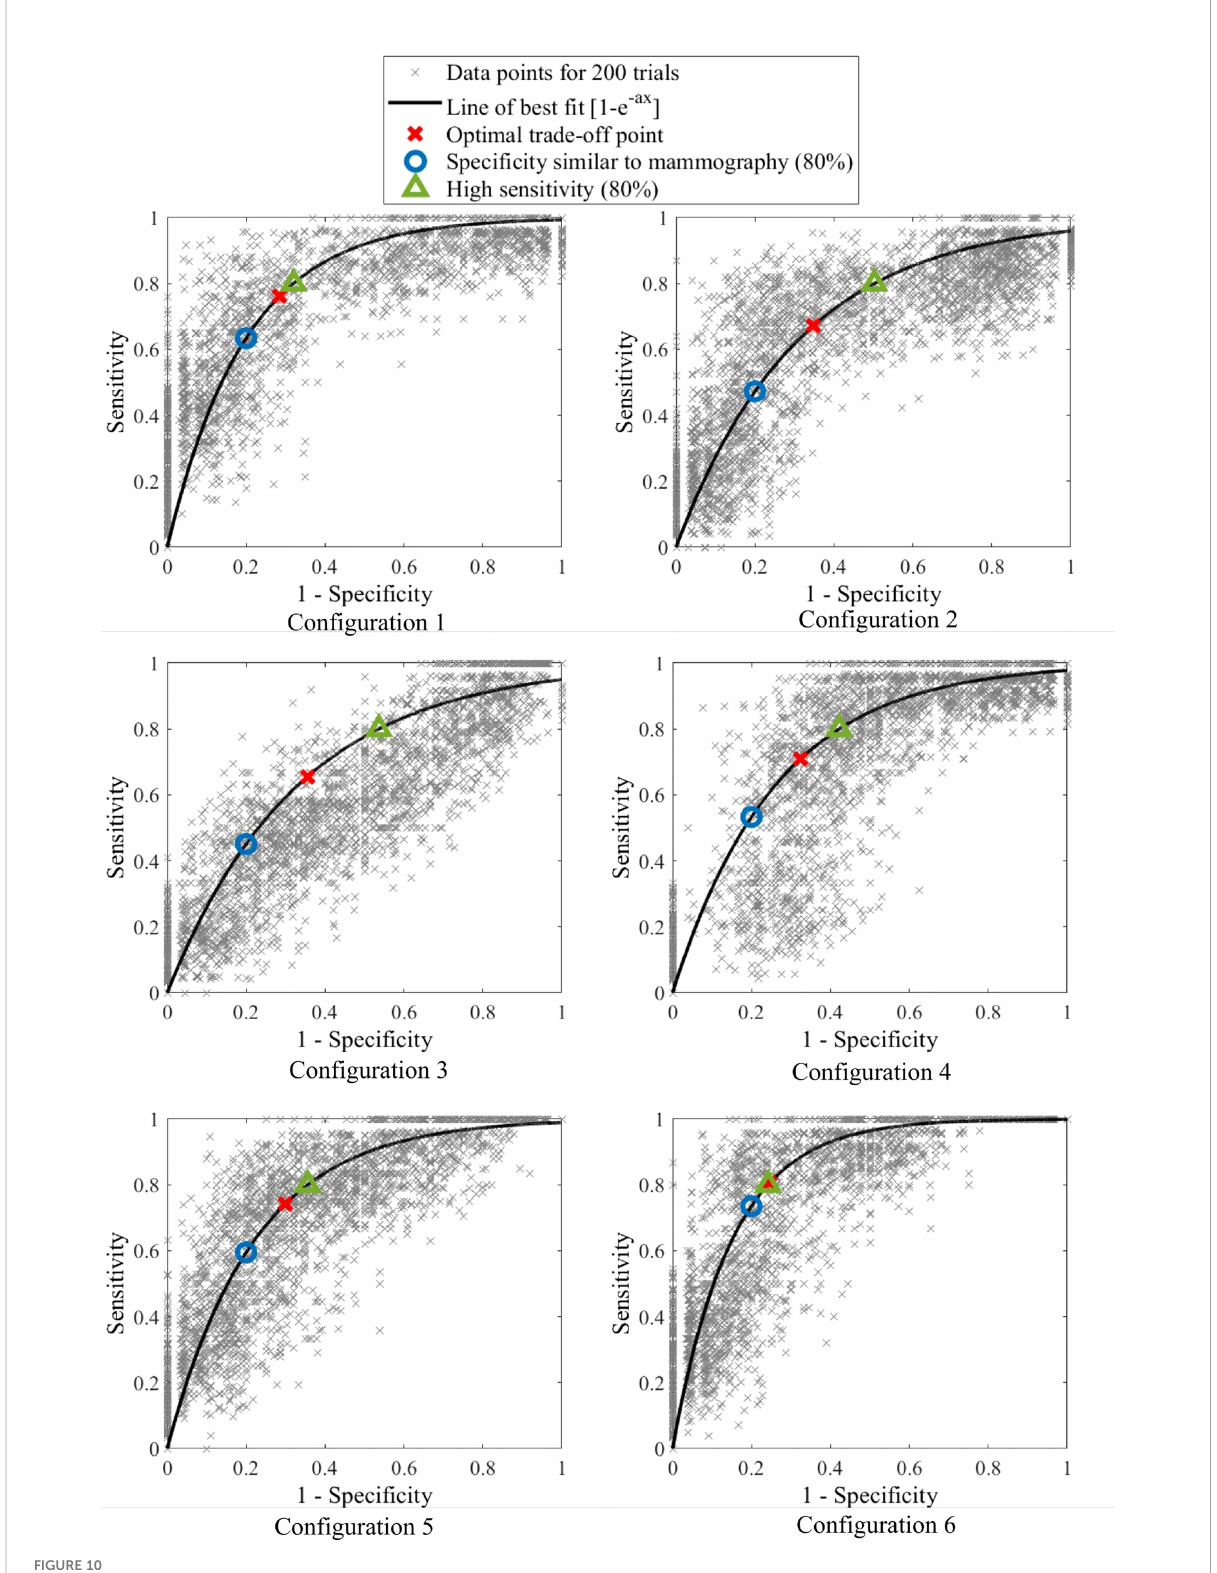
FIGURE 10 Bootstrapped ROC curves for breast con fi gurations